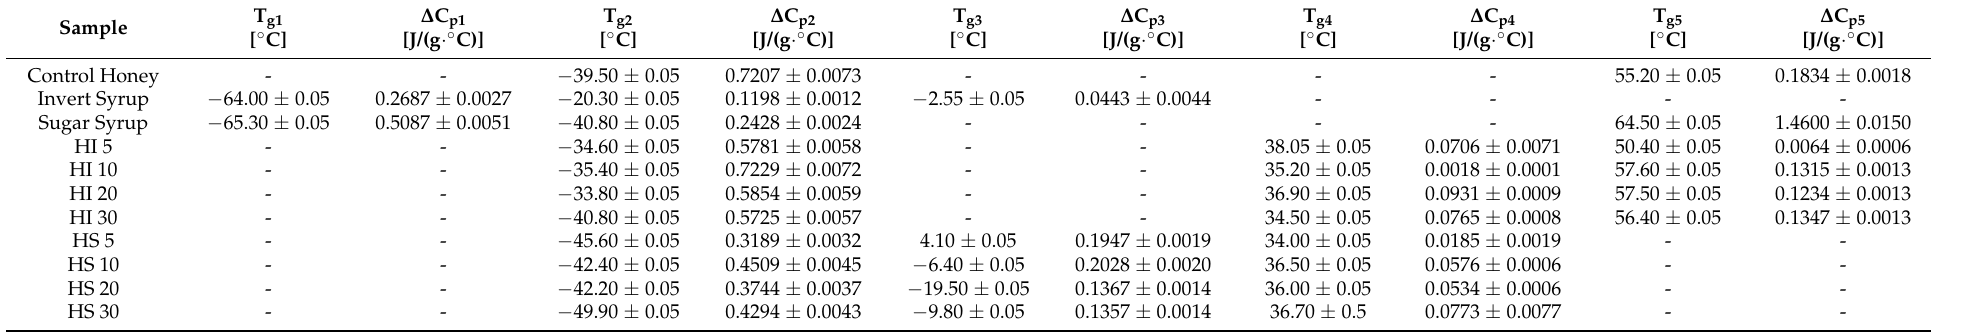
Table 3. Comparison of thermal parameters of control honey, syrup, invert, and adulterated honey samples (mean ±